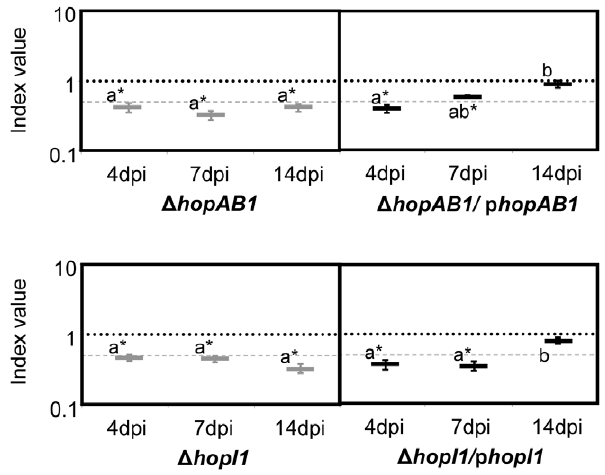
Figure 4. Complementation analysis of D hopAB1 and D hopI1 . The mutant strains carrying a plasmid expressing the corresponding effector from their native promoter were co-inoculated with the wild type strain and samples were taken at different time points (4, 7 and 14 dpi). Competitive indices are the average of three replicates per experiment. The assays were repeated twice with very similar results. The CIs of the relevant mutants are included (grey) for comparison purposes. A dashed line corresponding to a CI=0.5 is included for reference. Error bars represent the standard error. Asterisks indicate results significantly different from one, as established by Student’s t-test (P , 0.05). Mean values marked with the same letter (a or b) indicate results not significantly different from each other, as established by One Way ANOVA and Holm-Sidak test for multiple comparison ( P , 0.05).